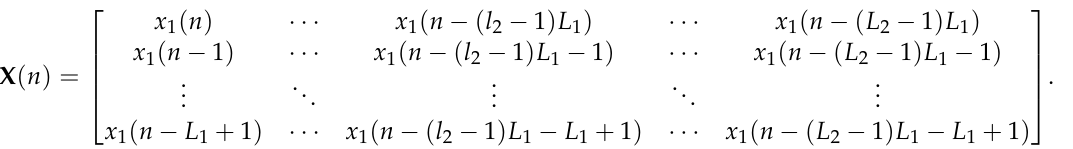
Figure 4. The two combiner levels structure based on transversal